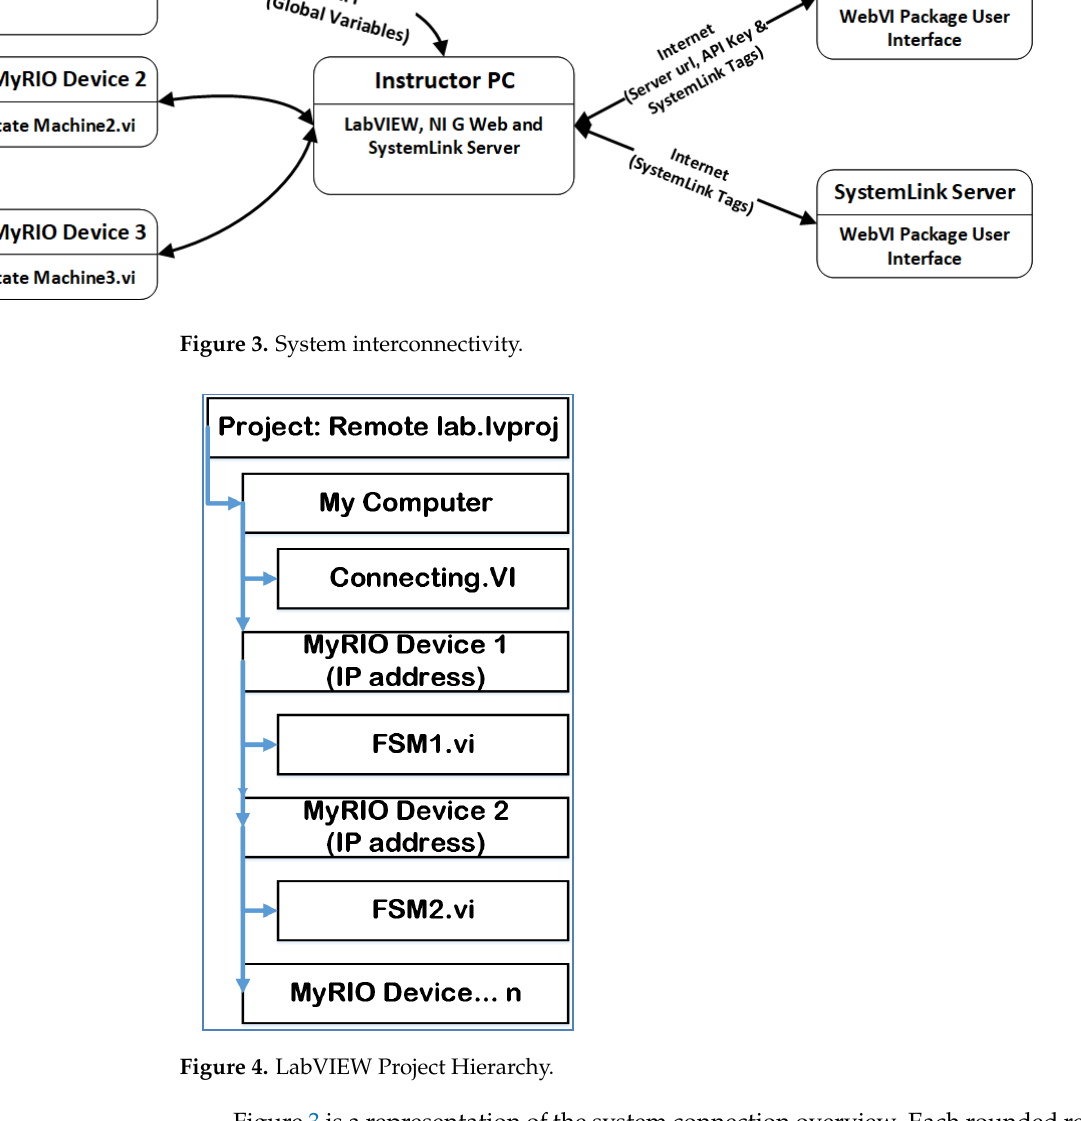
Figure 4. LabVIEW Project Hierarchy.